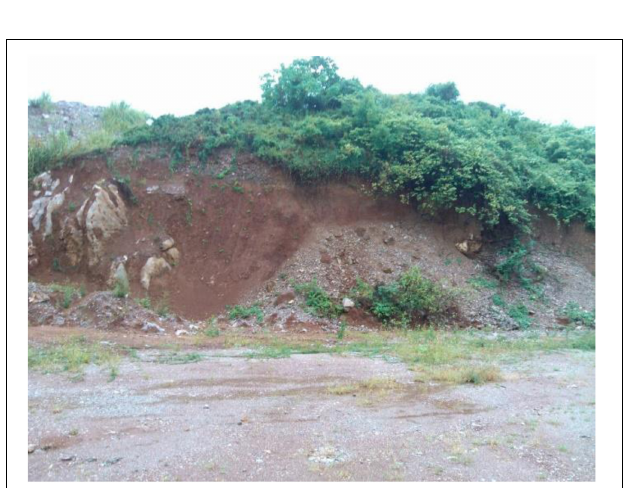
FIGURE 2 | Red clay slopes encountered during highway excavation in the study